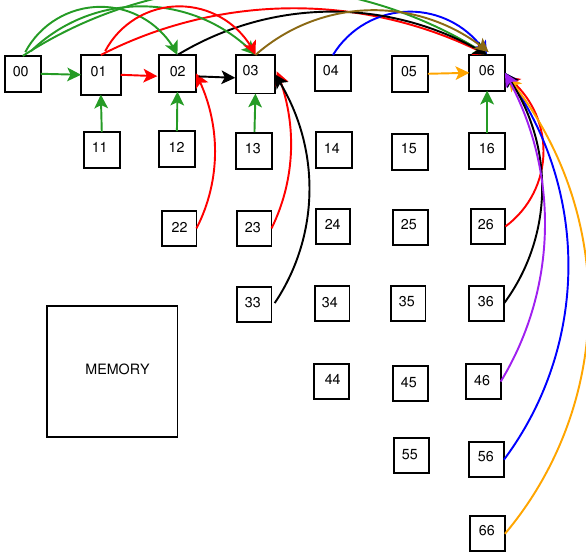
Figure 1. Calculation model to update